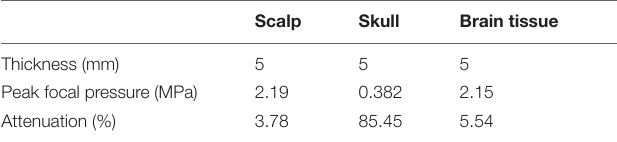
TABLE 2 | With the same thickness, ultrasound attenuation percentage of different head tissues. Scalp Skull Brain tissue Thickness (mm) 2.19 0.382 2.15 3.78 85.45 5.54